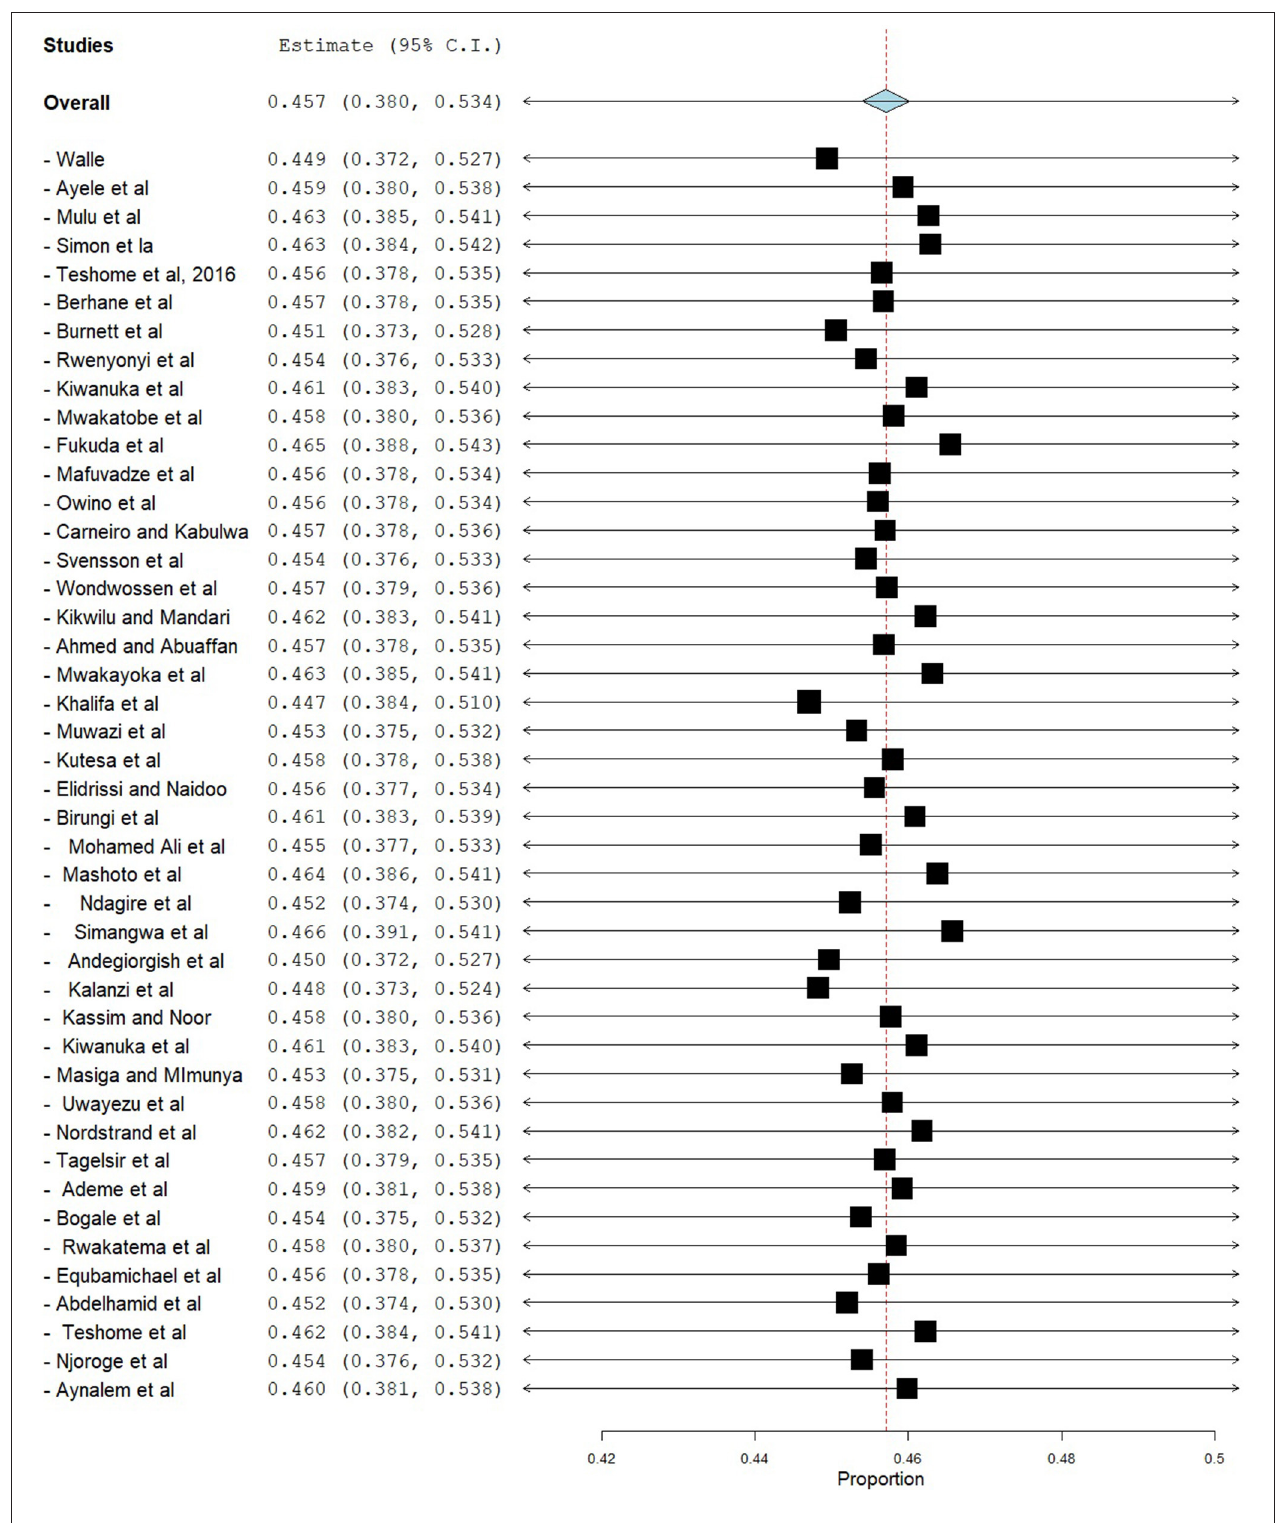
FIGURE 6 | Sensitivity